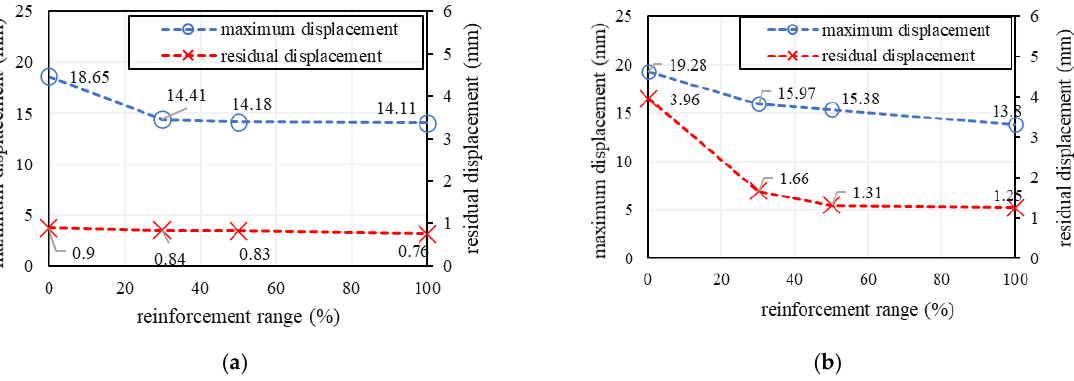
Figure 30. Comparison of maximum displacement and residual displacement of TYPE-B: ( a ) wave A; ( b ) wave B.